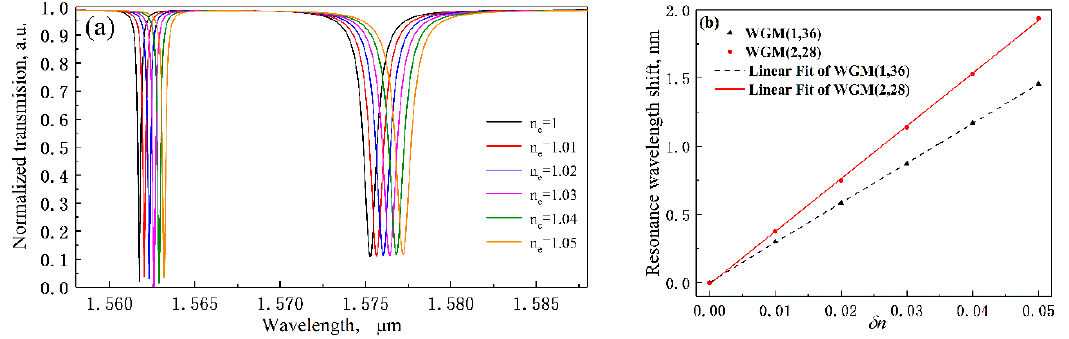
Figure 5. ( a ) The transmission spectra of the MDR with different RI of the surrounding environment. ( b ) Resonance wavelength shifts of the MDR versus the δ n .